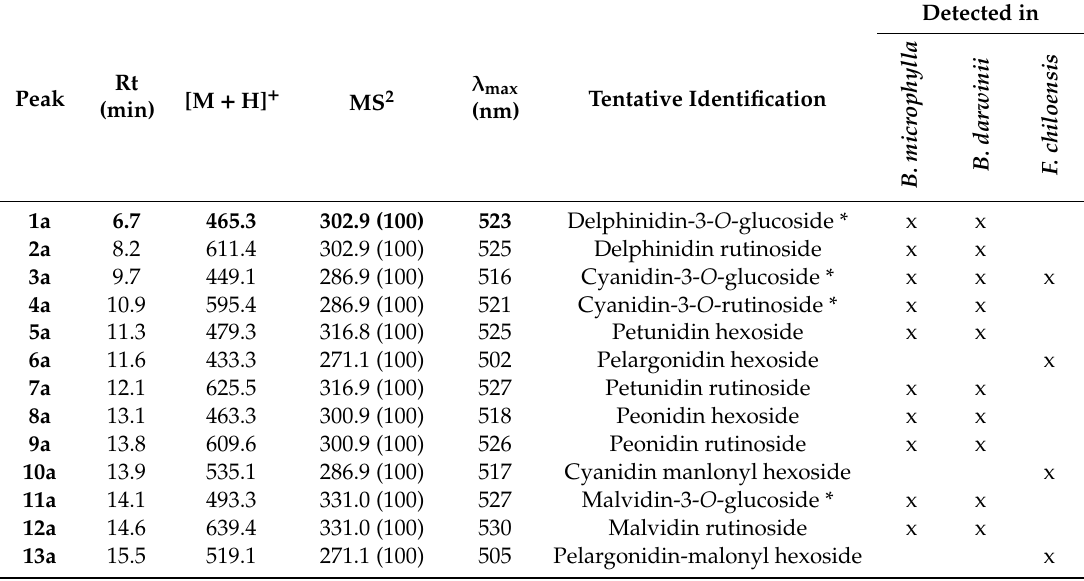
Table 2. Characterization and distribution of anthocyanins in Argentinean Patagonia Berberis micropylla , B. darwinii , and F. chiloensis berries by HPLC-DAD-ESI-MS n